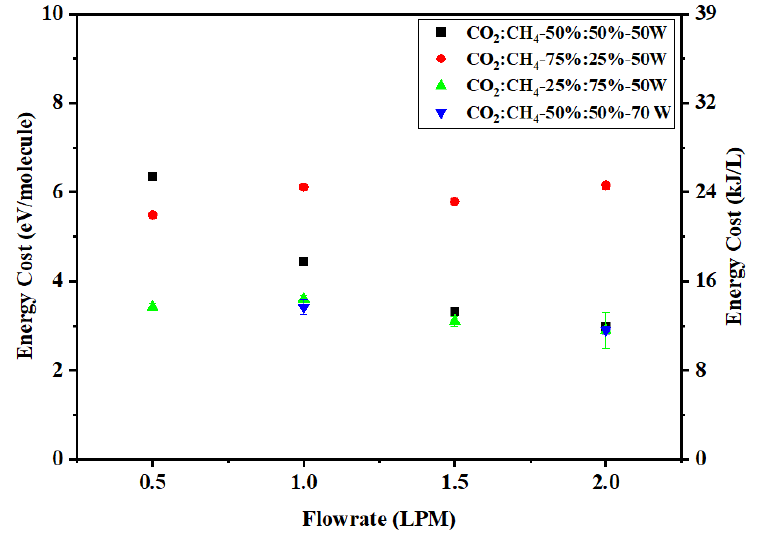
Figure 9. Effect of flow rate on energy cost.